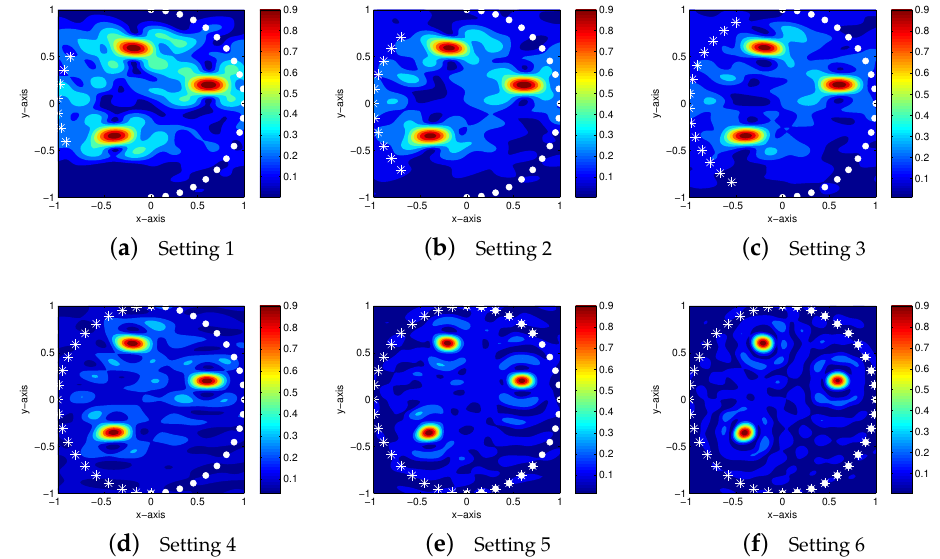
Figure 3. Maps of f SM ( x ) . White colored marks o and (cid:63) denote the incident and observation directions,